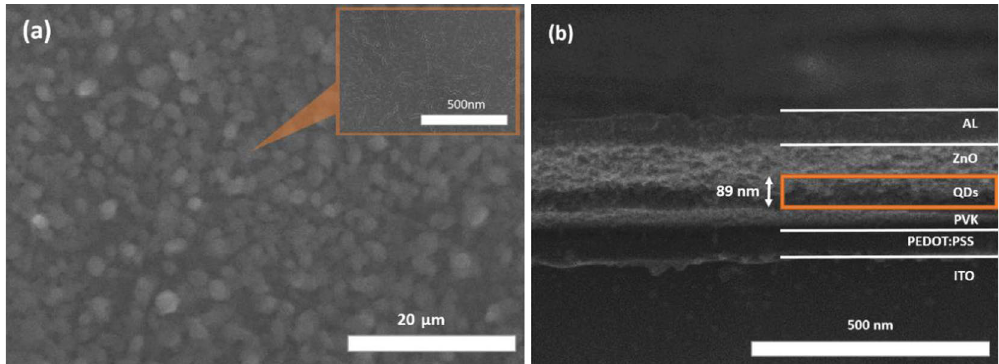
Figure 4. ( a ) SEM image of QD clusters of thin film after electrospray, and (b) cross-sectional SEM image of QD-LED device of ITO/PEDOT:PSS/PVK/QDs/ZnO/Al multi-structure.